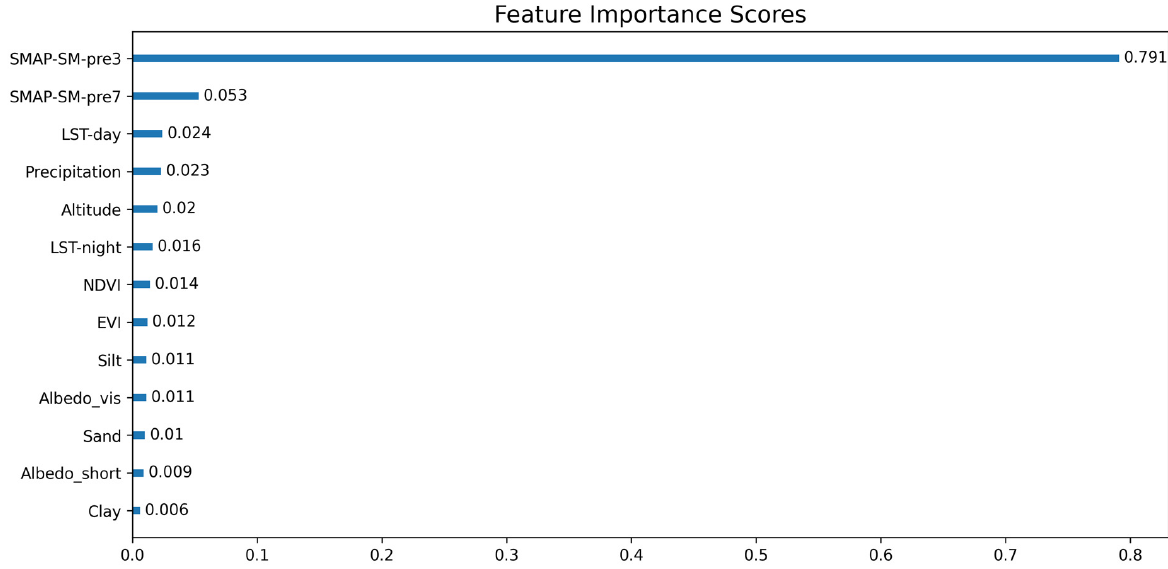
Figure 5. Rank of the importance of variables in RF model. SMAP-SM-pre3 = 3-day lagged SM; SMAP-SM-pre7 = 7-day lagged SM; LST-day = land surface temperature during day time; LST-night = land surface temperature during the night; Albedo_vis = albedo of visible band; Albedo_short = albedo of shortwave band.